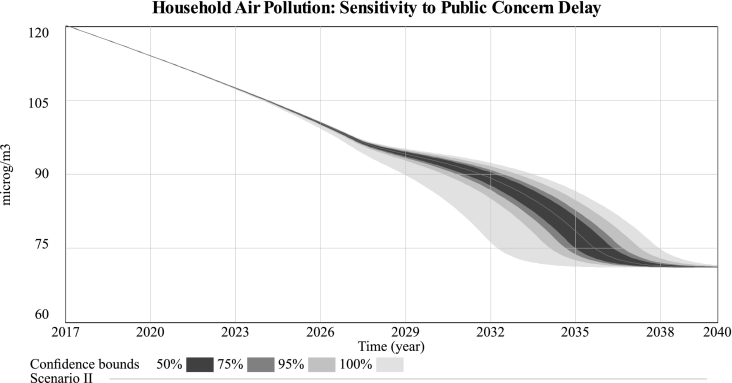
Sensitivity of household air pollution to public concern delay.